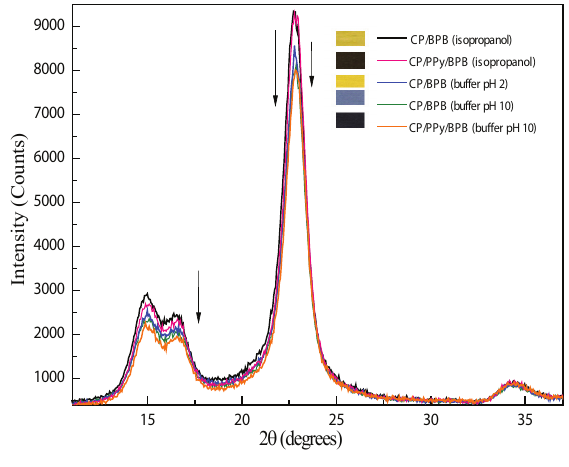
Figure 3: XRD patterns of CP/BPB (prepared in isopropanol and standard buff er solutions at pH 2 and pH 10) and